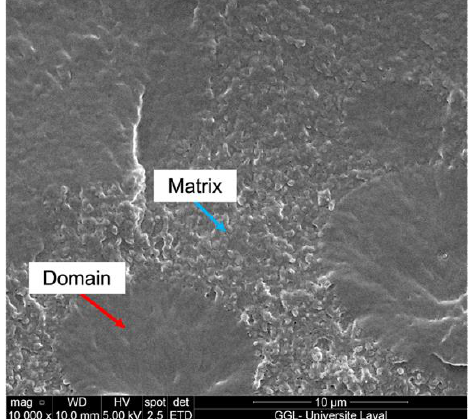
Figure 4. SEM cross-section images of the film prepared from the 5 wt.%